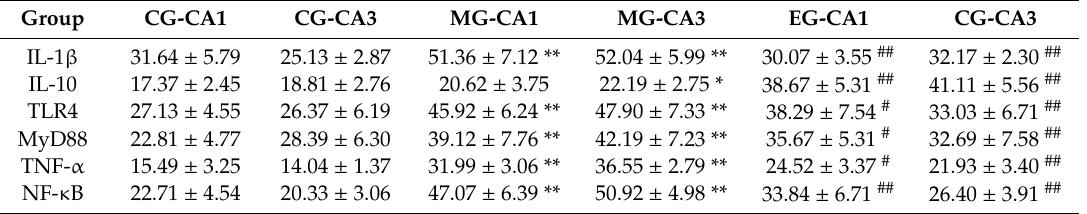
Table 3. Effects of aerobic exercise on the expression of inflammation-related factors in hippocampal CA1 and CA3 regions of depressed mice ( n = 6).